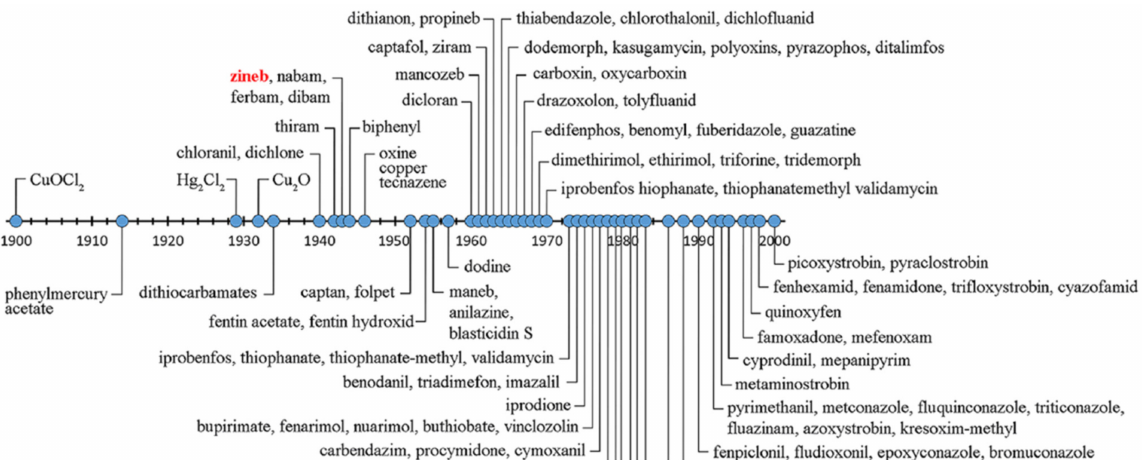
Figure 2. Timeline of the development of fungicides, showing the appearance of DTFs from 1930s onwards. Reproduced from [1], with